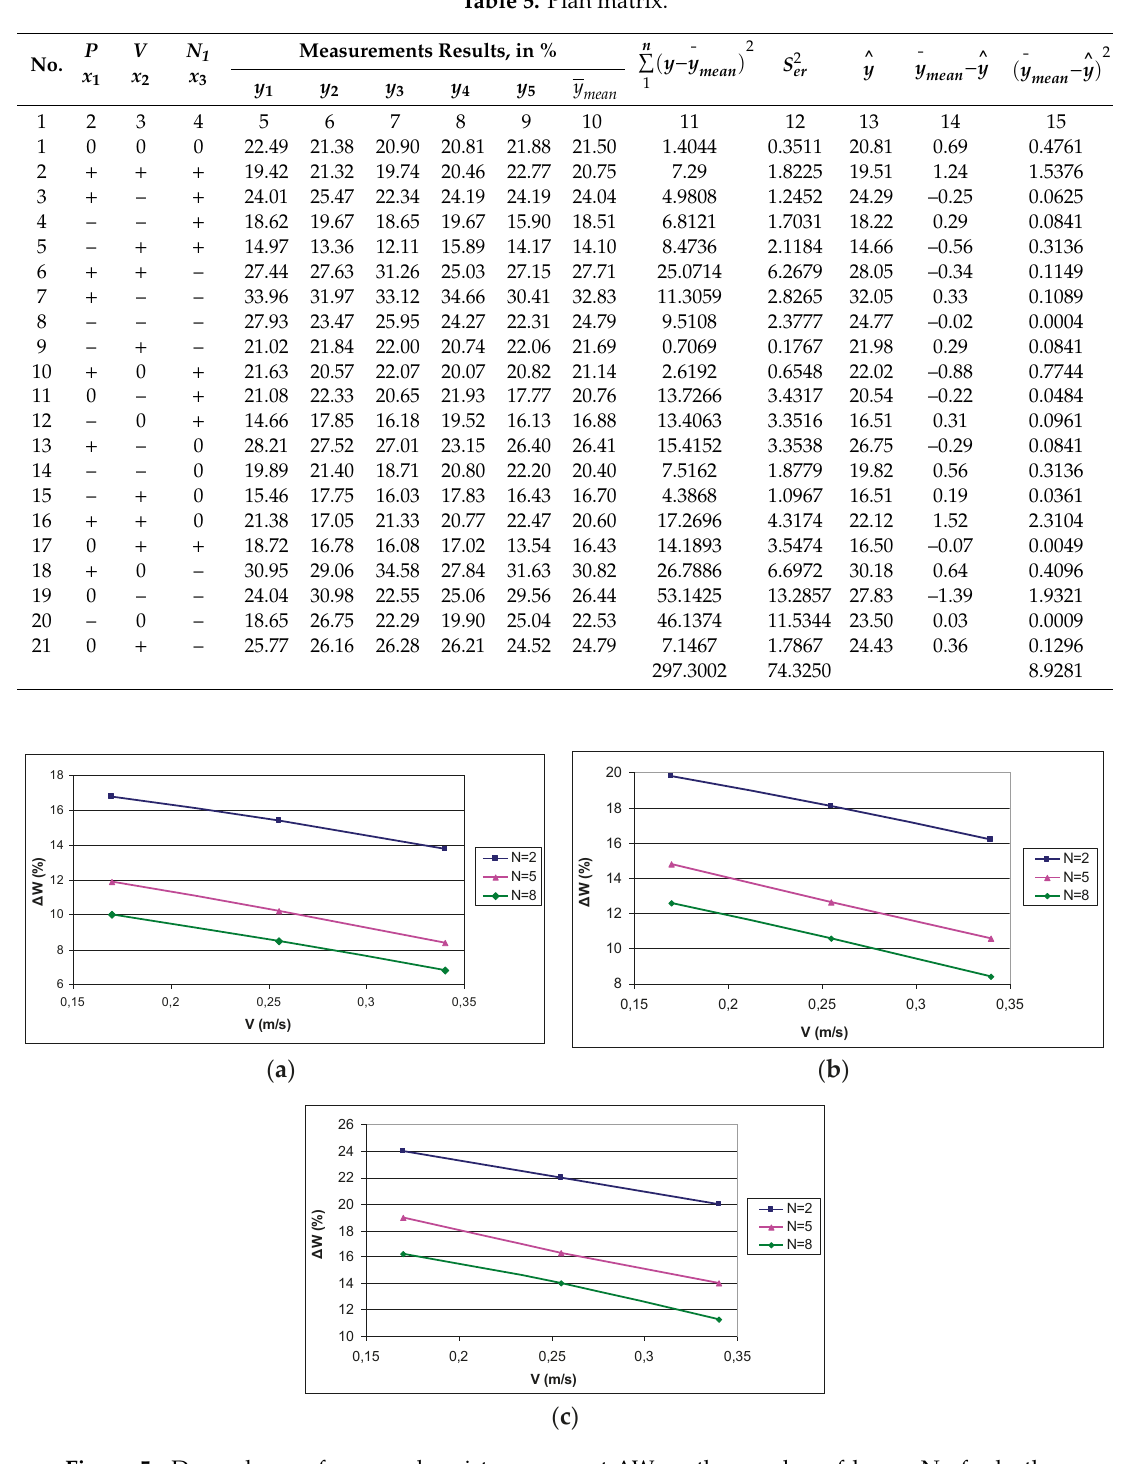
Figure 5. Dependence of removed moisture amount Δ W on the number of layers N of a leather semi-finished product between compression rolls at a compression intensity: P = 32 kN/m ( a ), P = 64 kN/m ( b ), P = 96 kN/m ( c ); at the leather semi-finished product thickness N = 2 pieces (pcs), N = 5 pcs, and N = 8 pcs. Table 6. Experimental data on the moisture extraction from a wet leather semi-finished product.